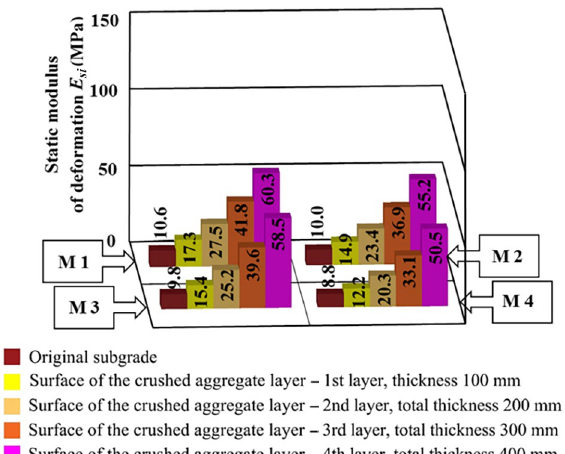
Figure 5. Values of the static modulus of deformation E si measured on the surface of the partial layers of the standard structural composition of the sub-ballast layers ( Segment A )